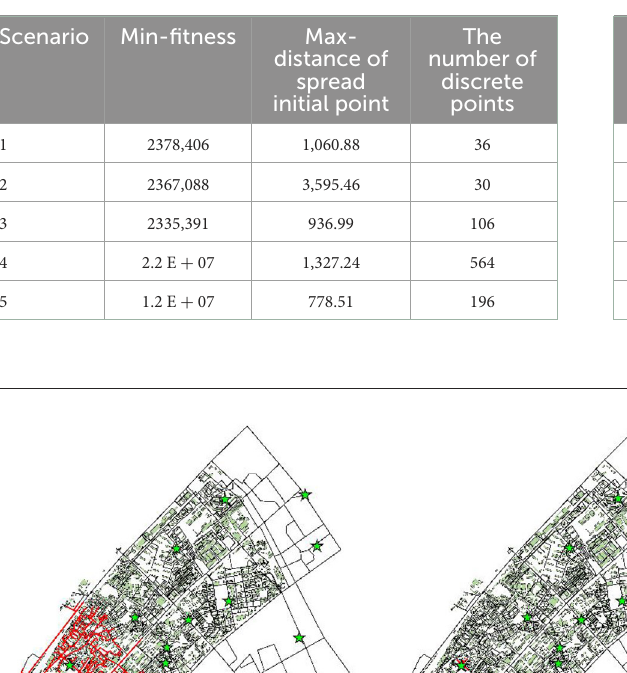
TABLE 5 The digitized results for each scenario. TABLE 6 The digitized results dimensionless processing.